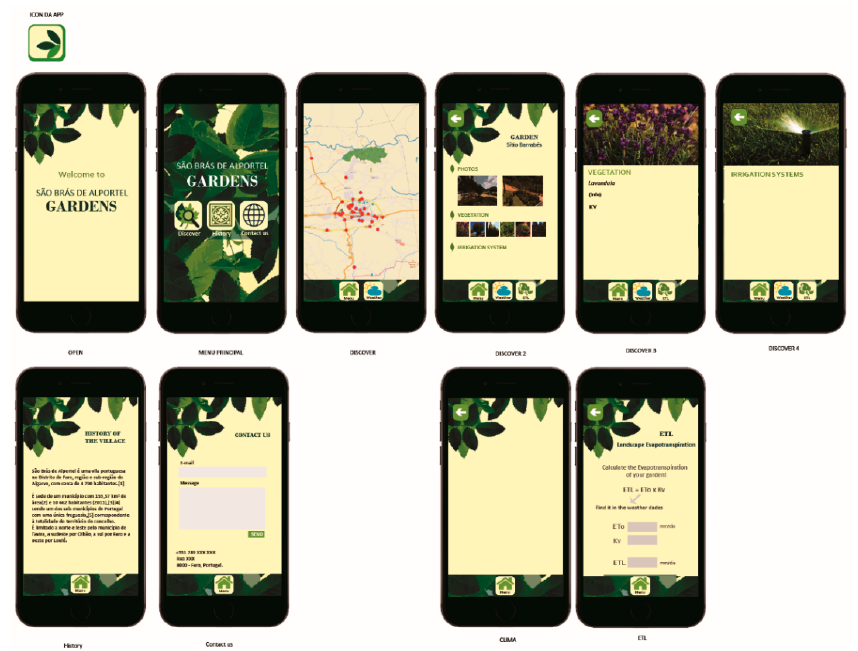
Figure 8. Application: São Bras de Alportel GARDENS.